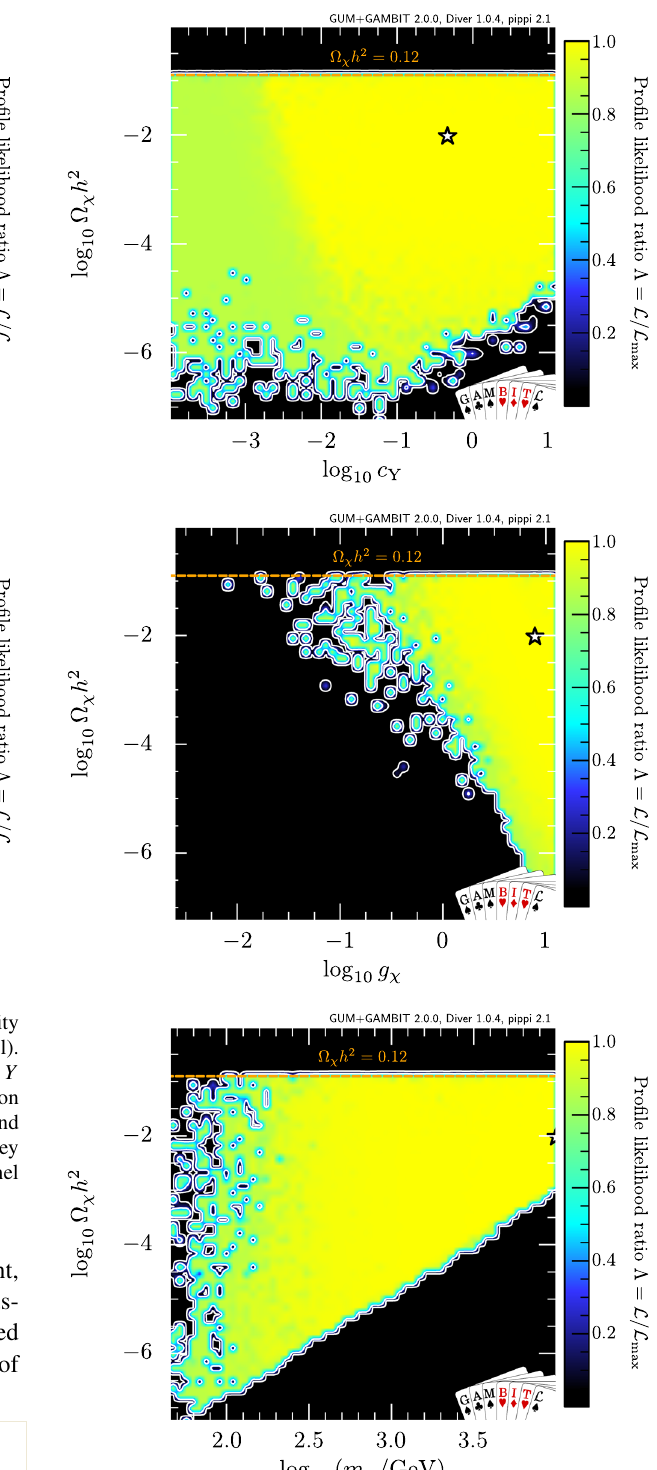
Fig. 2 Profilelikelihoodinthe Ω χ h 2 – c Y ,(top) Ω χ h 2 – g χ (centre),and Ω χ h 2 – m χ (bottom) planes. The orange dashed line shows the standard Λ CDM limit from Planck [106]. Contour lines show 1 and 2 σ confi- dence regions, and the white star the best-fit